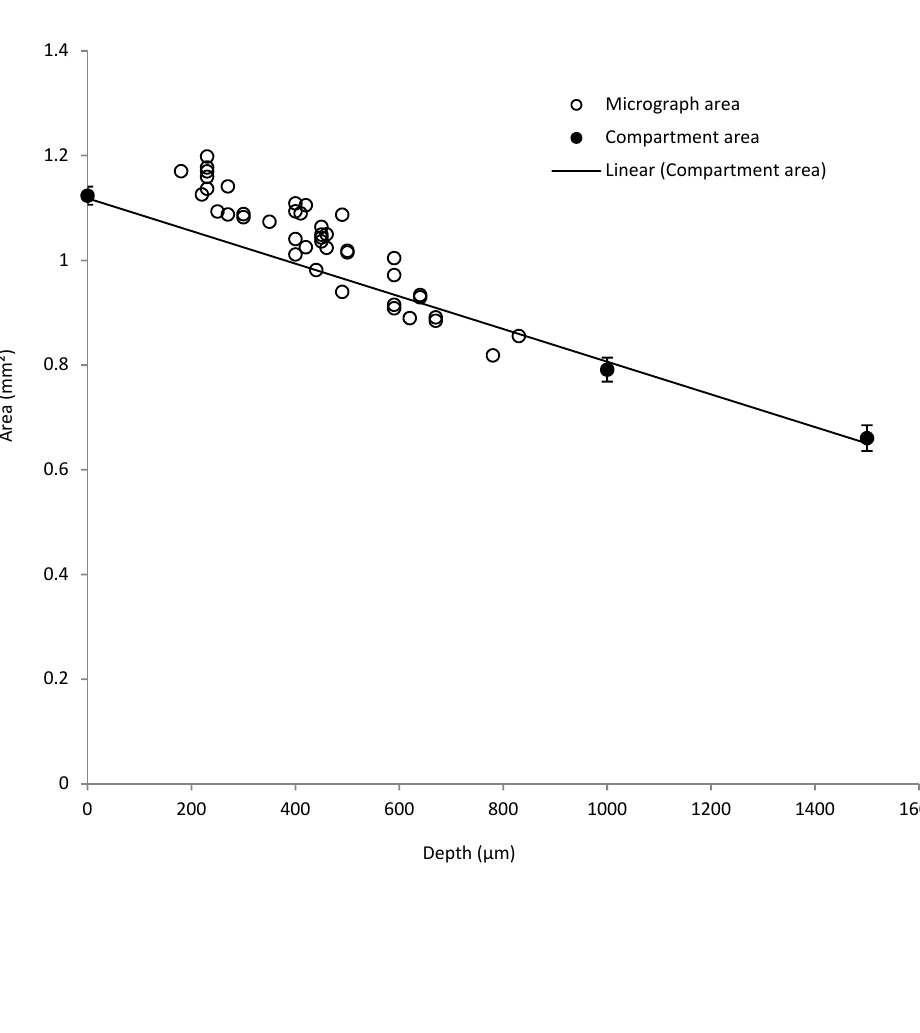
Figure S1. Scatter plot of area versus depth ( z ) for the assembled confocal micrographs (open circles) and Microchip compartment area as determined by light microscopy (closed circles). N.B. due to the production method the carrier area decreases with depth down to the mid-point of the carrier. That is, the total carrier compartment, from one carrier surface to the other, has a slight “waist” at the center. The area of the confocal micrographs was measured in the biofilm reference (Eub338) channel. Error bars = 95% confidence